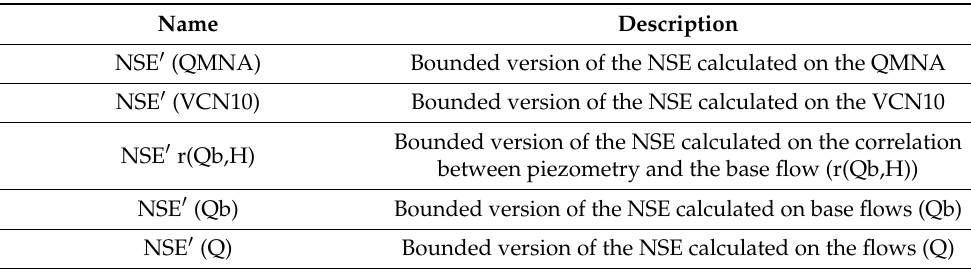
Table 3. Description of the NSE (cid:48) for different evaluation criteria.